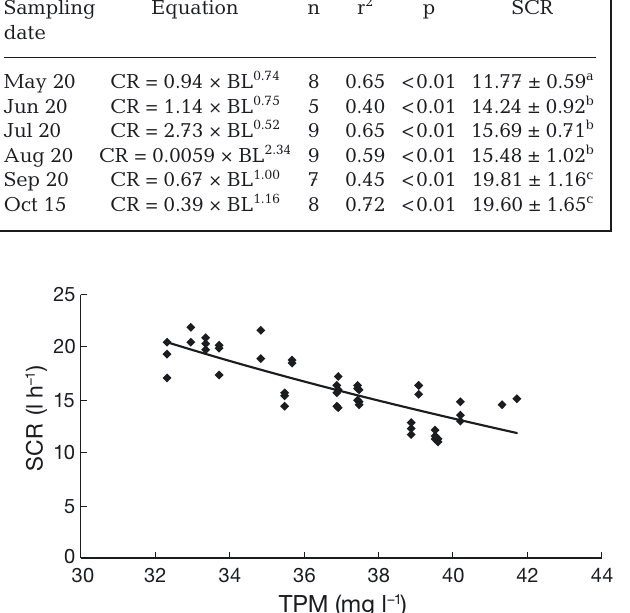
Fig. 2. Relationship between standardized clearance rate (SCR) of 30 cm silver carp Hypophthalmichthys molitrix and total particulate matter (TPM)